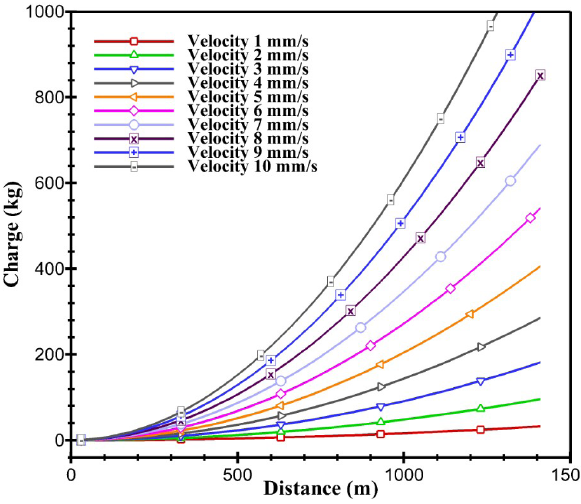
Figure 8: Safe charge weight per delay (Q) for different distances and